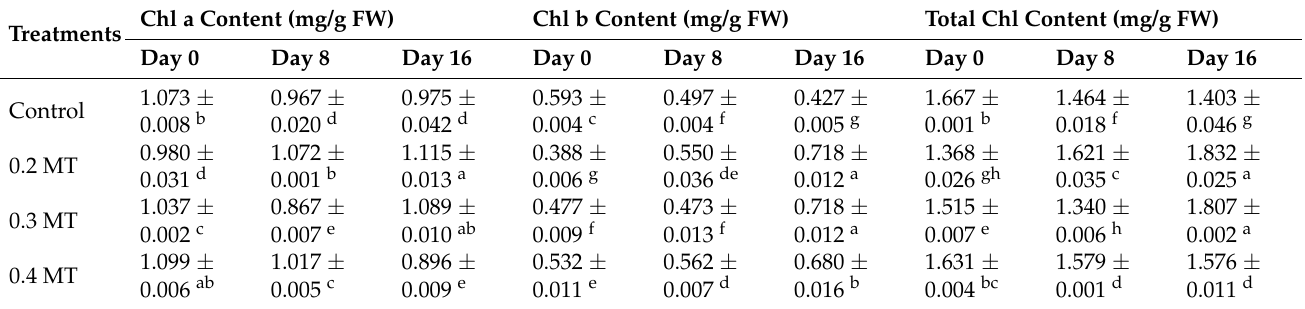
Table 1. Effect of exogenous melatonin on chlorophyll a, b , and total chlorophyll contents in tea leaves. Chl a Content (mg/g Treatments